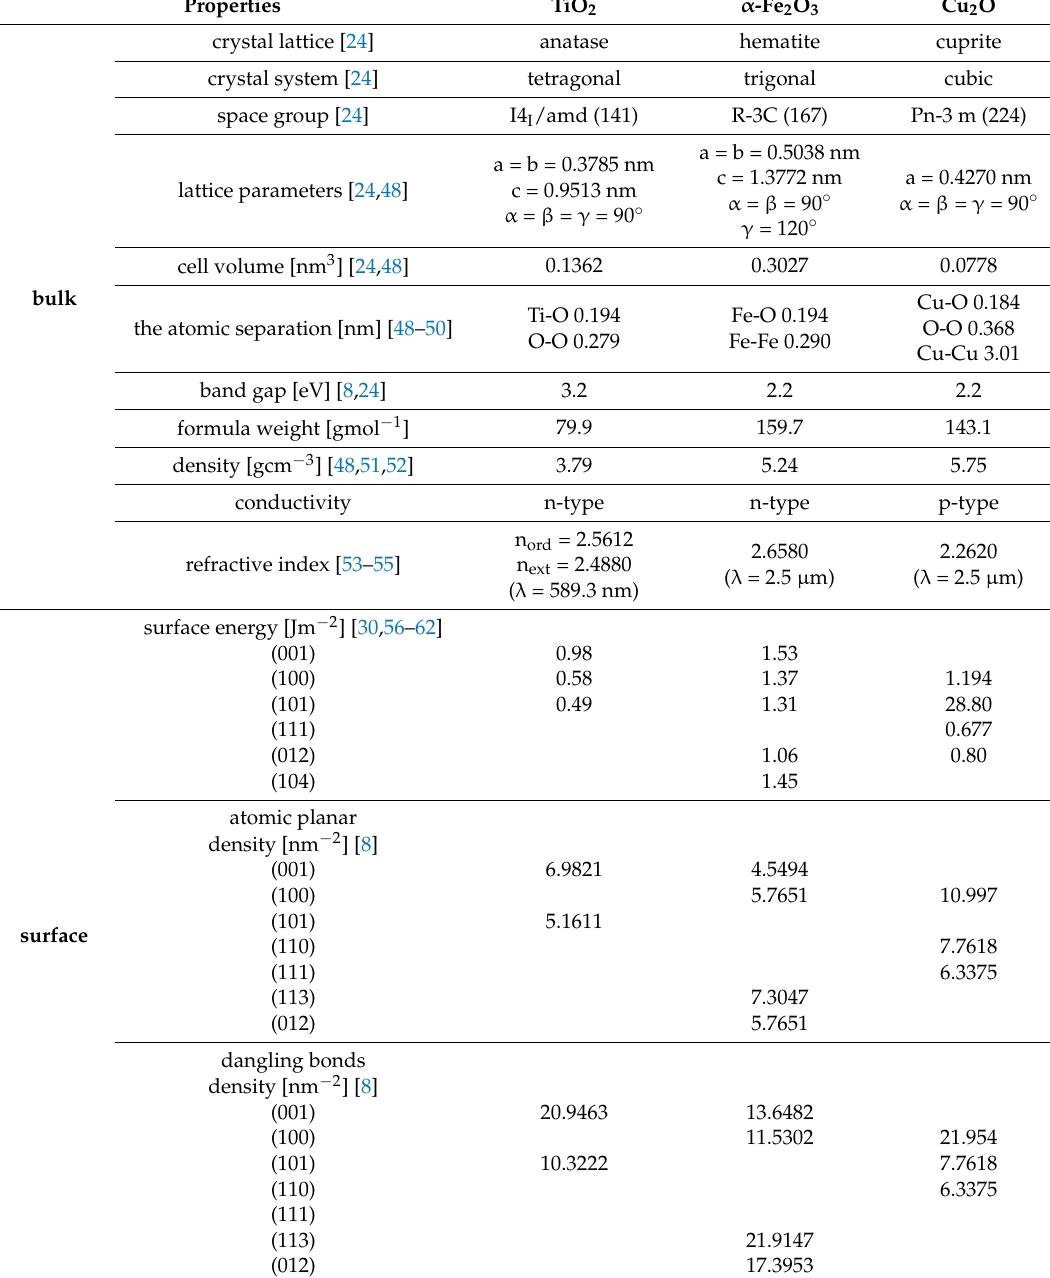
Table 1. Bulk and surface properties of TiO 2 , α -Fe 2 O 3 , and Cu 2